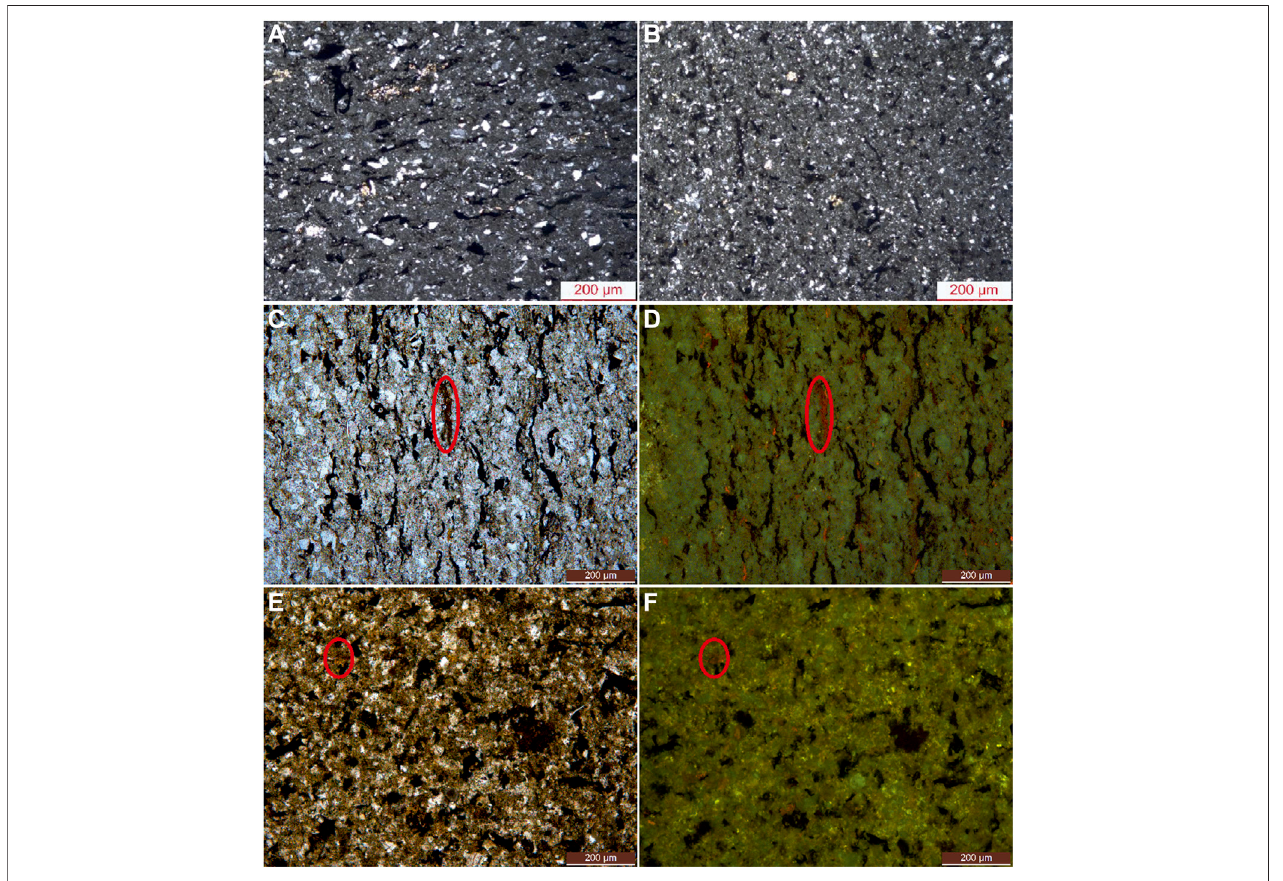
FIGURE 7 | Characteristics of pore connectivity in vertical thin sections (A) and horizontal thin section (B) of tight sandstone and fl uorescence characteristics of vertical section (C,E) and horizontal section (D,F) of tight sandstone.